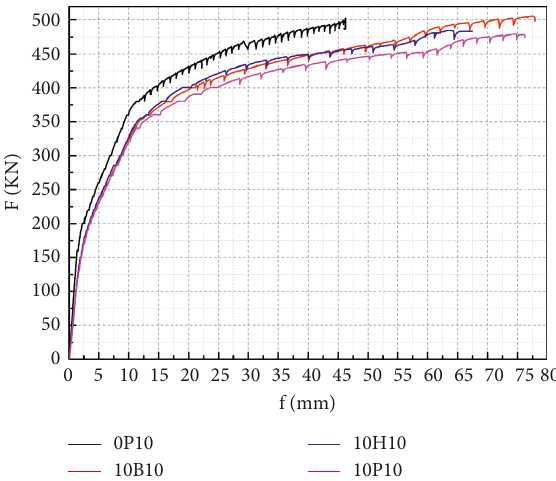
Figure 12: Load-deflection curves of the specimens.